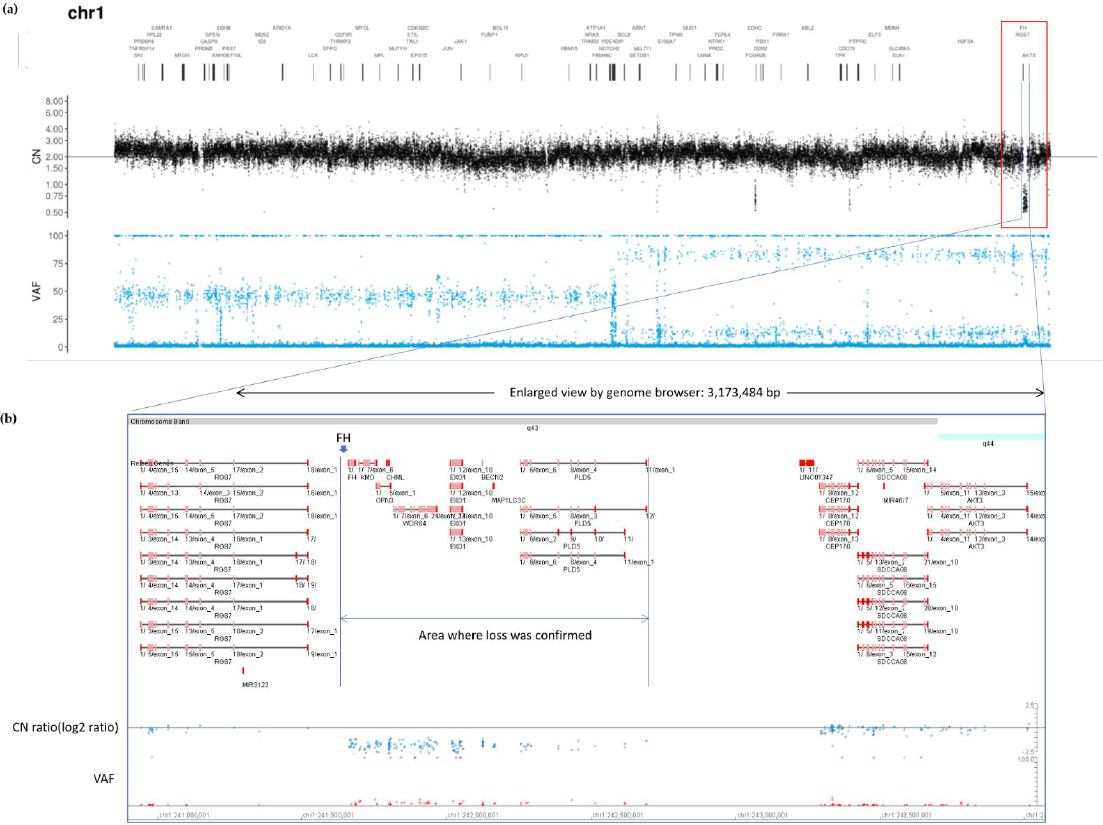
Figure 4. Tumor profiling data. All copy number (CN) relative ratio measurements are based on peripheral blood DNA as a control. ( a ) CN alteration (CNA) plot of full-length chromosome 1 in the tumor specimen (CN ratio of tumor tissue/normal tissue). A large homozygous deletion of approximately 3 Mb near FH was confirmed in the tumor sample. ( b ) Enlarged view using Genome Browser; a deletion was found in a large region encompassing FH. VAF, variant allele frequency; DNA, deoxyribonucleic acid.